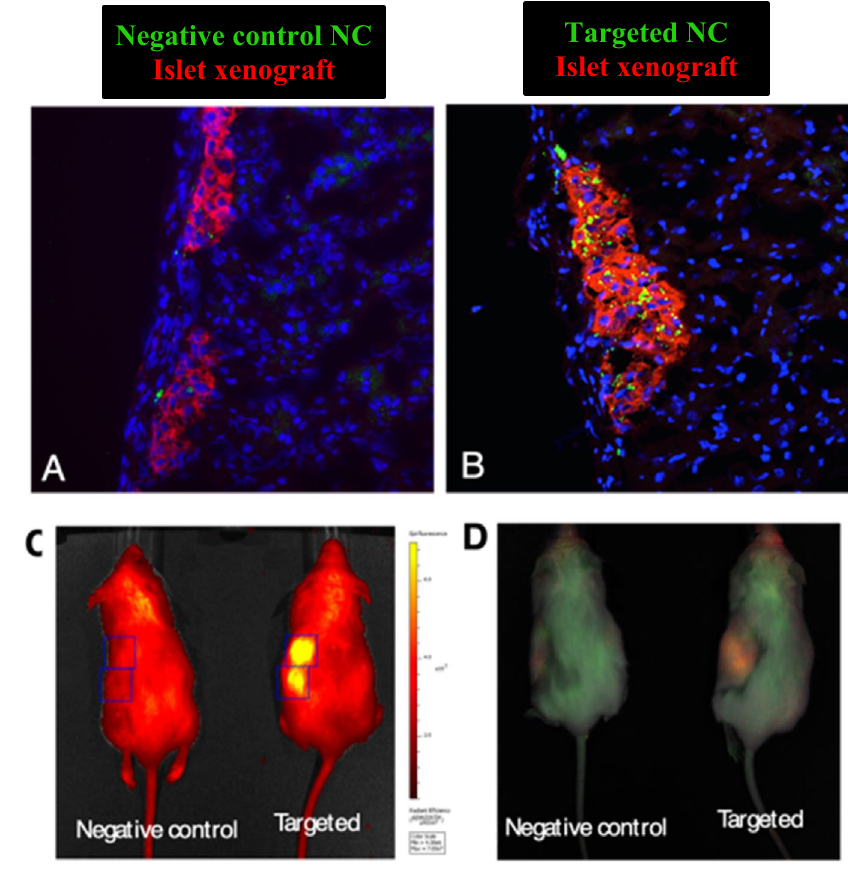
Figure 5. Representative images of human islet xenografts immunostained with HPi2 (red) antibody reactive to pancreatic endocrine cells to locate the graft in kidney sections of mice that received ( A ) QDot loaded negative control or ( B ) QDot loaded targeted, nanocarriers (green). The sections were counterstained with DAPI (blue). ( C , D ) Representative IVIS images from the Living Image 4.3.1 software of mice that received QDot loaded negative control (right) or targeted nanocarriers (left) under short isoflurane anesthesia. ( C ) Raw image before spectral unmixing ( D ) composite image obtained after multispectral imaging and spectral unmixing. The IVIS images were obtained at 48 h